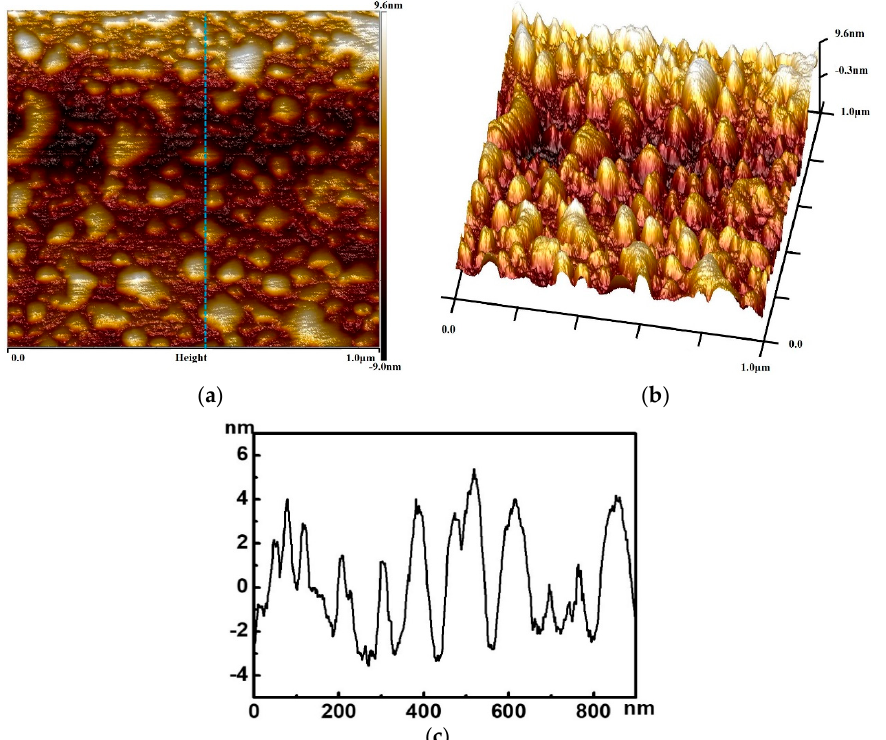
Figure 8. AFM ( a ) 2D and ( b ) 3D images of albite treated with 2.38 × 10 ‒ 4 mol/L DDA at pH 5.5, and ( c ) thickness of adsorbed DDA layer on the surface of albite.